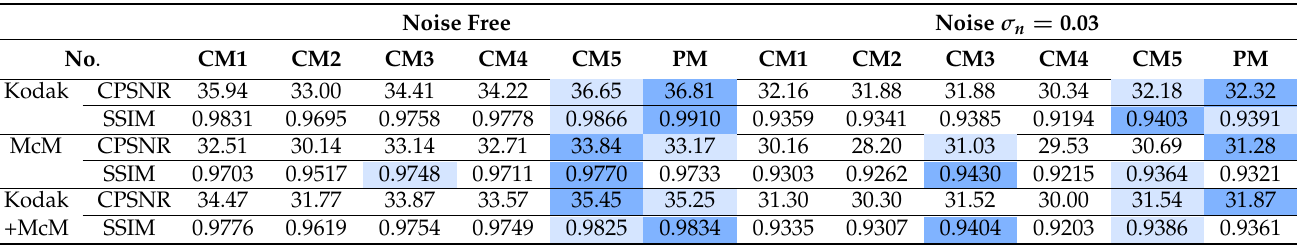
Table 2. Total Average CPSNR(DB) and SSIM of the Kodak and McMaster dataset (Noise-free and with σ = 0.03).